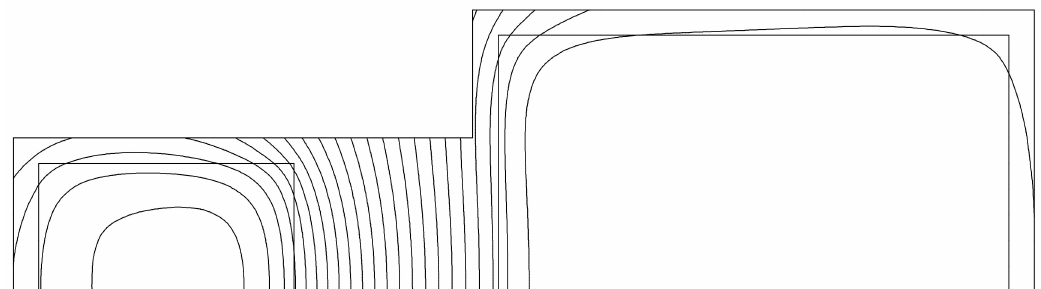
Figure 11. Contours of the real part of the magnetic vector potential.